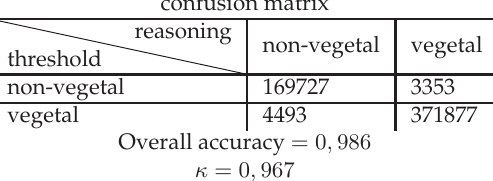
Table 1: Evaluation of ontological classification approach: confusion matrix comparing reasoning to threshold for vegetal semantics.